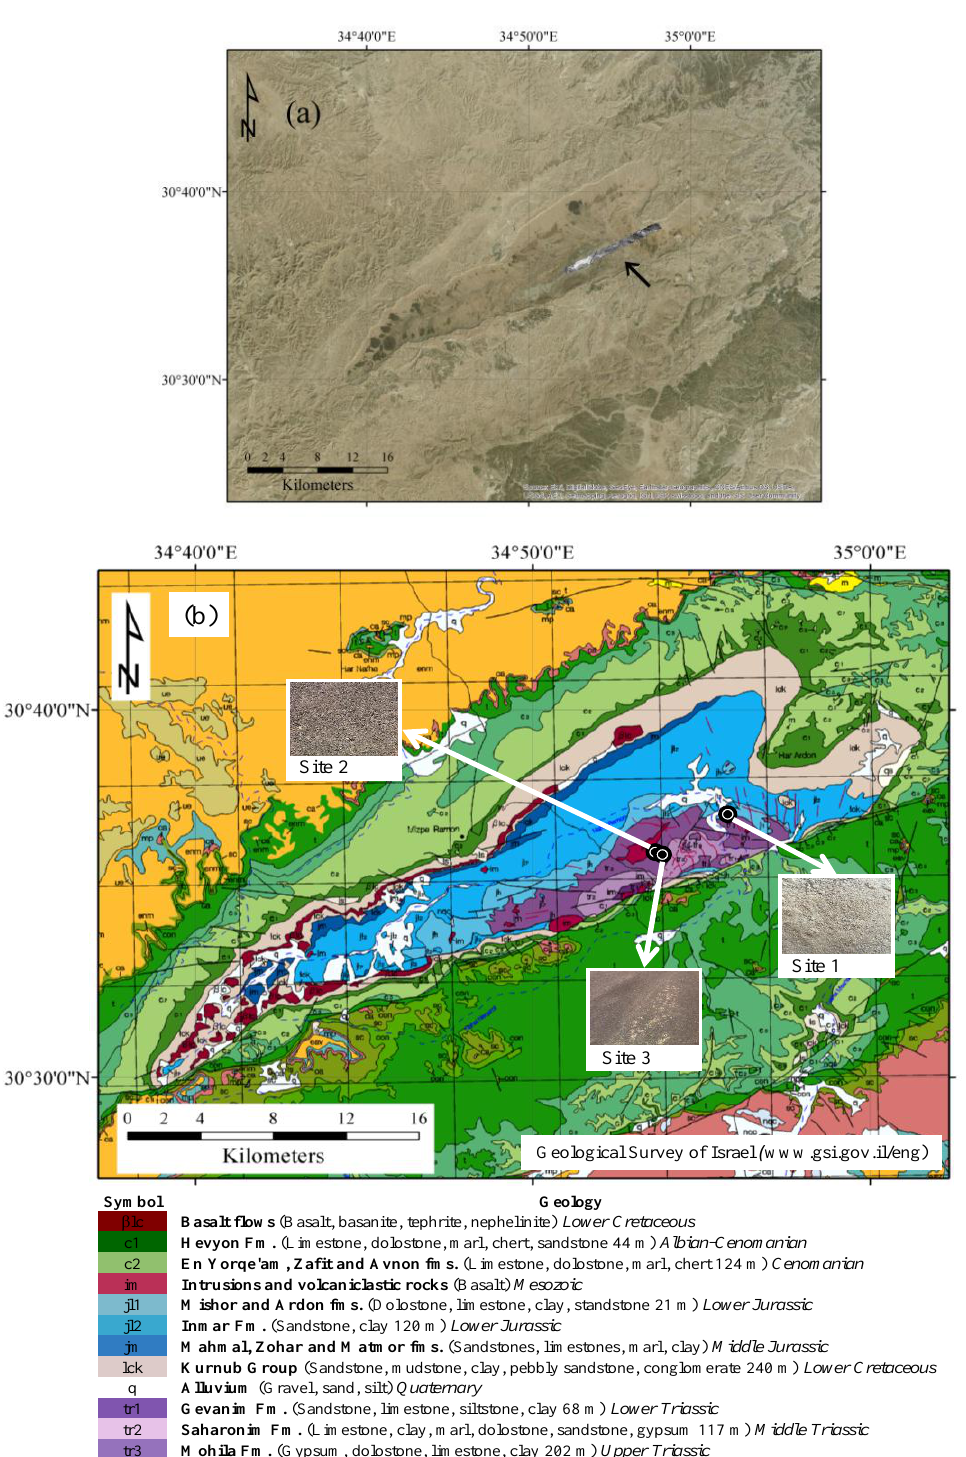
Figure 1. ( a ) The study area (image source: Esri, DigitalGlobe, GeoEye, Earthstar Geographics, CNES/Airbus DS, USDA, USGS, AEX, Getmapping, Aerogrid, IGN, IGP, swisstopo, and the GIS User Community); arrow indicates the acquired LWIR image (band 10.60 μm, day image); ( b ) Geological map of the area (source: Geological Survey of Israel). The photographs show the surface of about 4 square meters of three sites, out of seventeen sites, which were sampled for the ground truth dataset, as described in Section